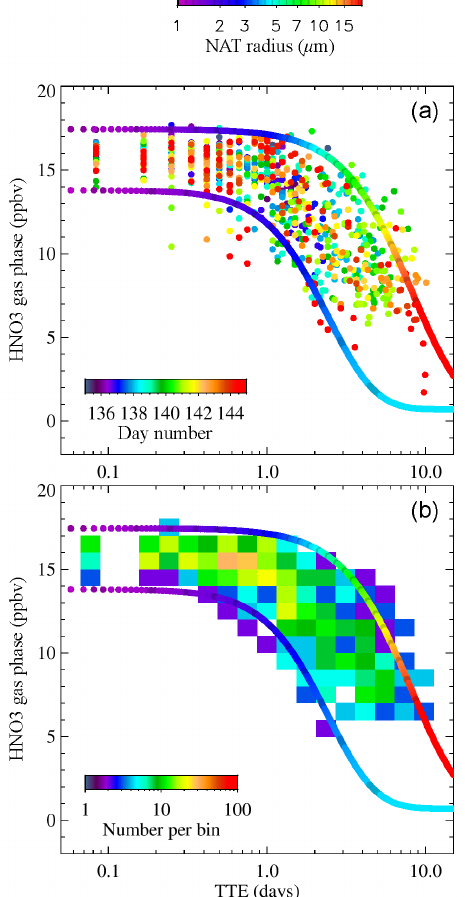
Figure 12. MLS HNO 3 on the 32hPa pressure level over the 10-day period from 15 to 24 May 2009 (days 135–144) in the Antarctic po- lar vortex. Data are selected only if there are no coincident PSC detections by CALIOP. (a) Scatter plot of individual HNO 3 values vs. TTE. The colored dots indicate the measurement day number (given in the inset color bar). The two colored curves are from a calculation of the gas-phase HNO 3 , assuming growth of NAT at a constant temperature of T ICE + 4K for NAT number densities and initial total HNO 3 values of 5 × 10 − 5 cm − 3 and 18ppbv, respec- tively, for the upper curve and 5 × 10 − 4 cm − 3 and 14ppbv for the lower curve. The top color bar indicates the NAT radius. (b) As in (a) except plotted as a 2-D histogram of the density of points, with the inset color bar giving the number of samples per bin. Only bins accumulating two or more data points are